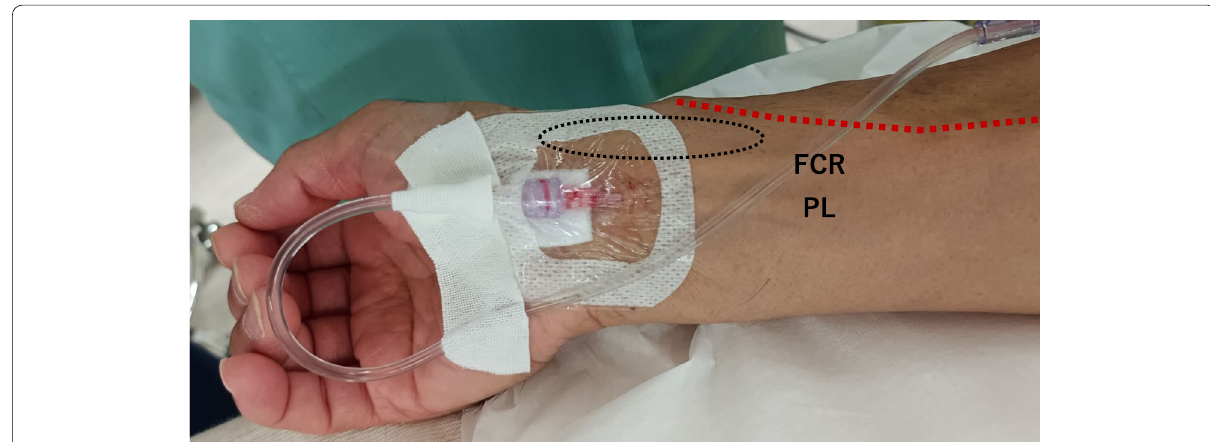
Fig. 1 Incidental arterial cannulation of the median artery. An arterial catheter was placed between the flexor carpi radialis (FCR) tendon and the palmaris longus (PL) tendon, at the concordance of the running course of the median nerve. The superficial radial artery, an anatomical variation of the radial artery, was dominant to the radial artery in our patient (red line). Therefore, the pulse was difficult to palpate in the distal forearm where the radial artery usually runs